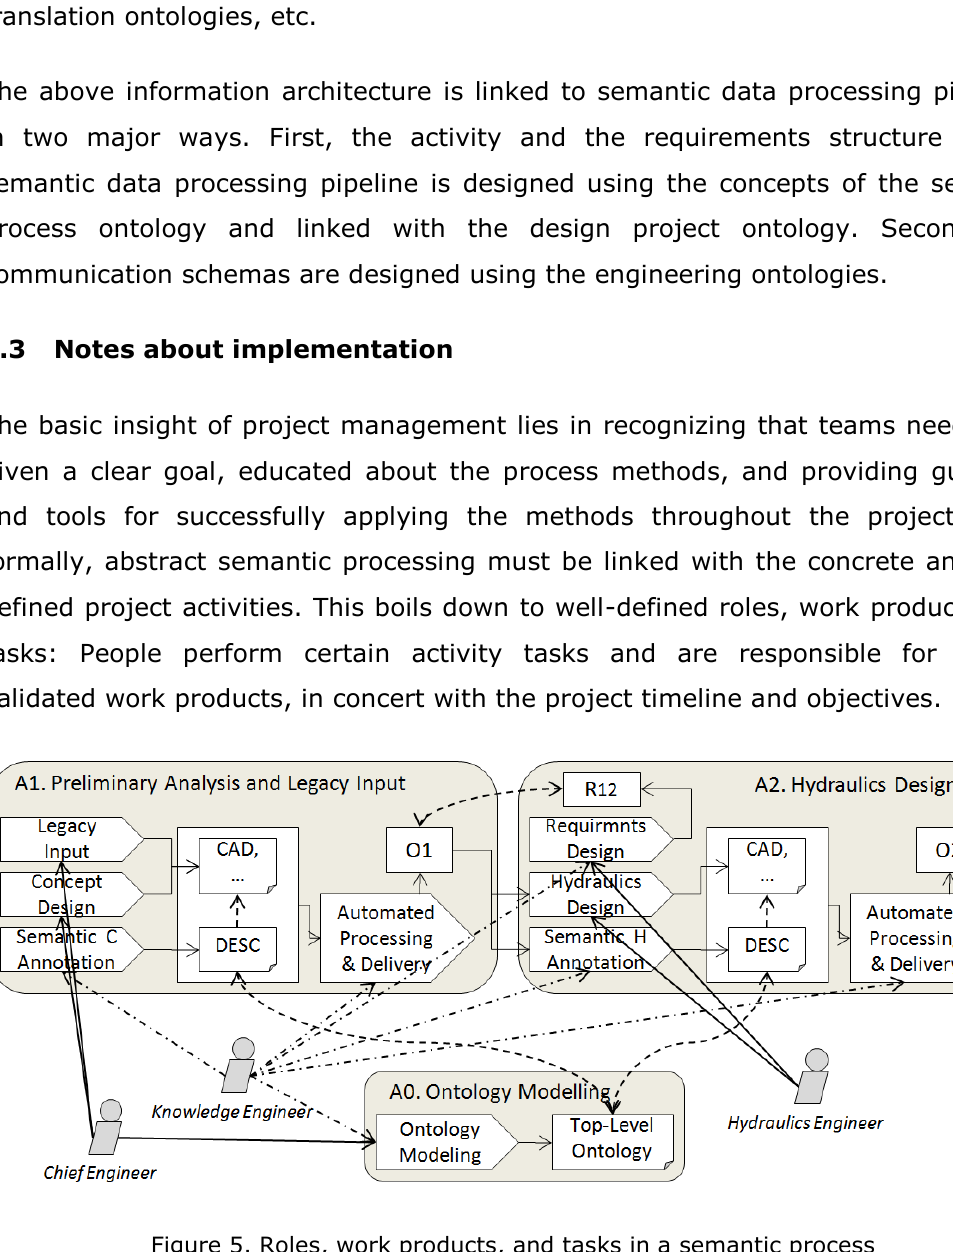
Figure 5. Roles, work products, and tasks in a semantic